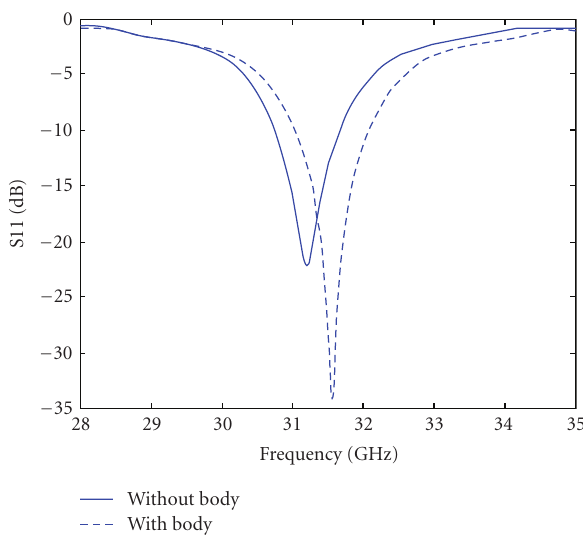
Figure 4: Return loss of the antenna with and without the body.